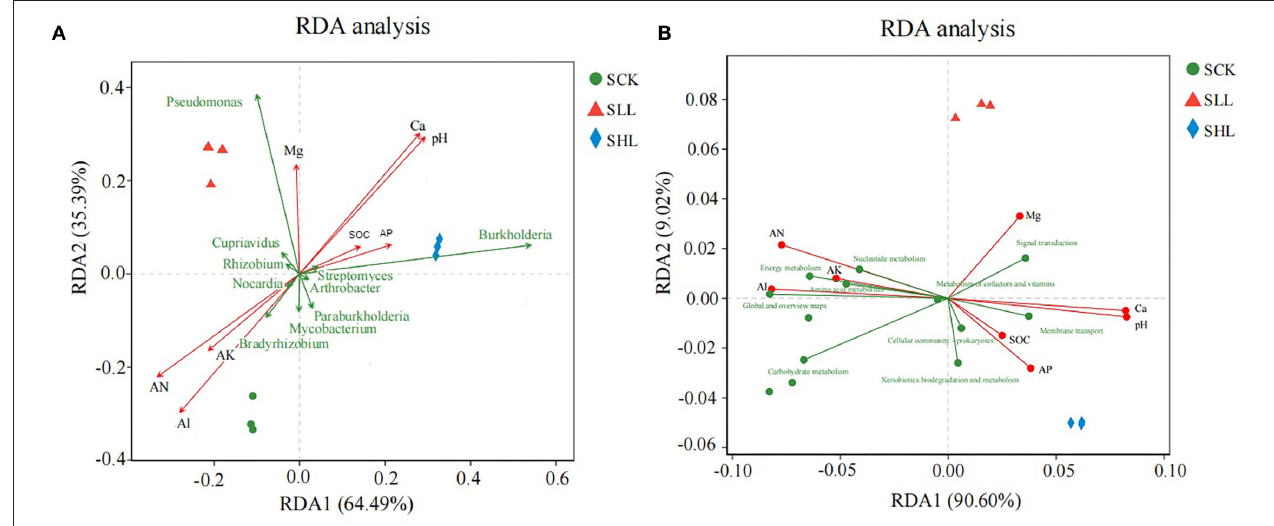
FIGURE 6 | Redundancy analysis plots of the correlation between the structure (A) and function (B) of the microbial community in HLB-infected citrus rhizoplane and environmental factors during the neutralization of soil acidity.